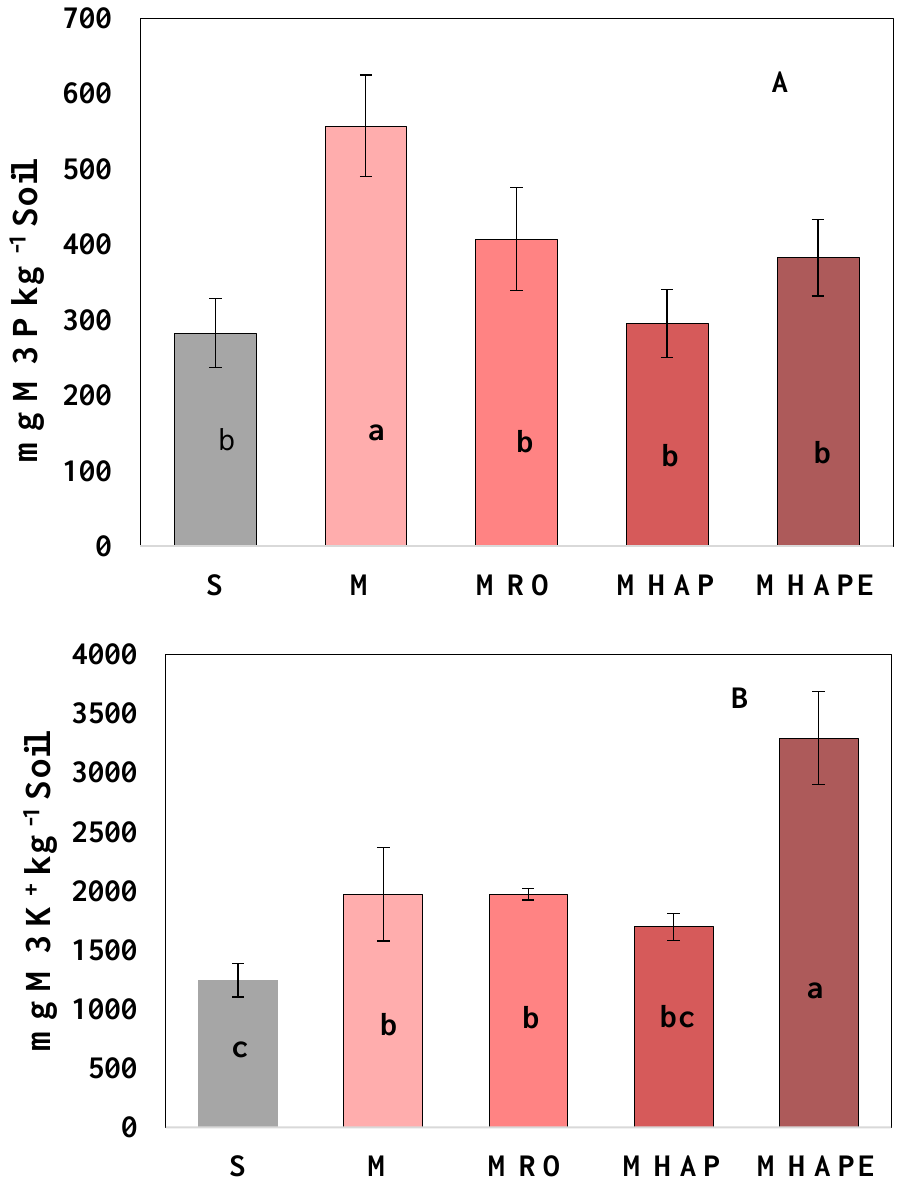
Figure 6. The effect of treatments on Mehlich3 (M3) extractable soybean soil P ( A ), and K ( B ) concentrations. The mean was calculated for n = 4; the vertical bar represents the standard deviation of the mean. Here, S = soil control; M = manure control; MRO = manure + red oak biochar; MHAP = manure + highly alkaline porous biochar; MHAPE = manure + corn feedstock autothermal porous Fe-engineered biochar. Different letters show the treatments that are statistically different at p < 0.05